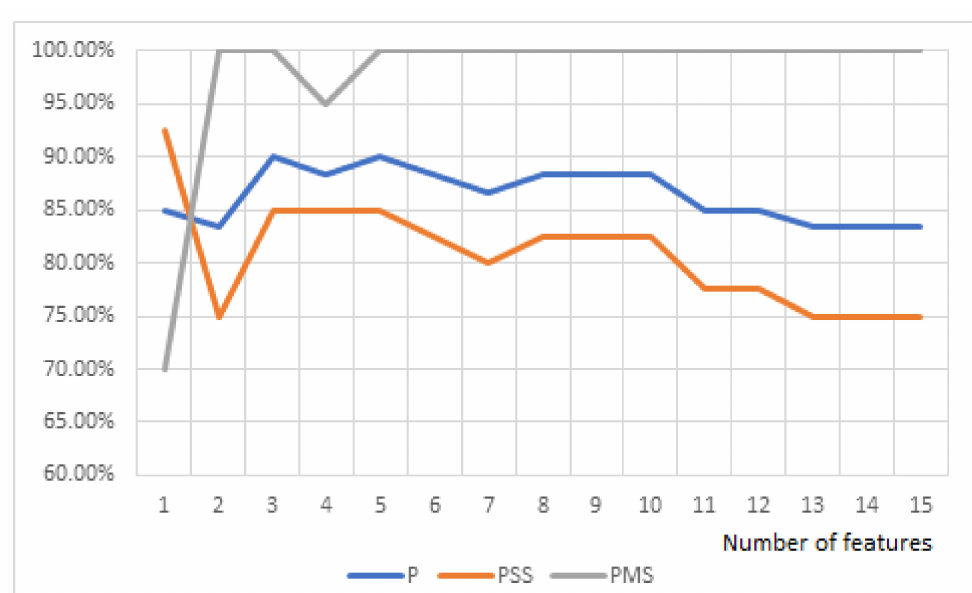
Figure 6. Feature evaluation for SM